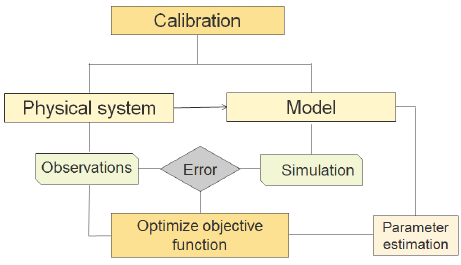
Figure 2. Conceptualization of model calibration.